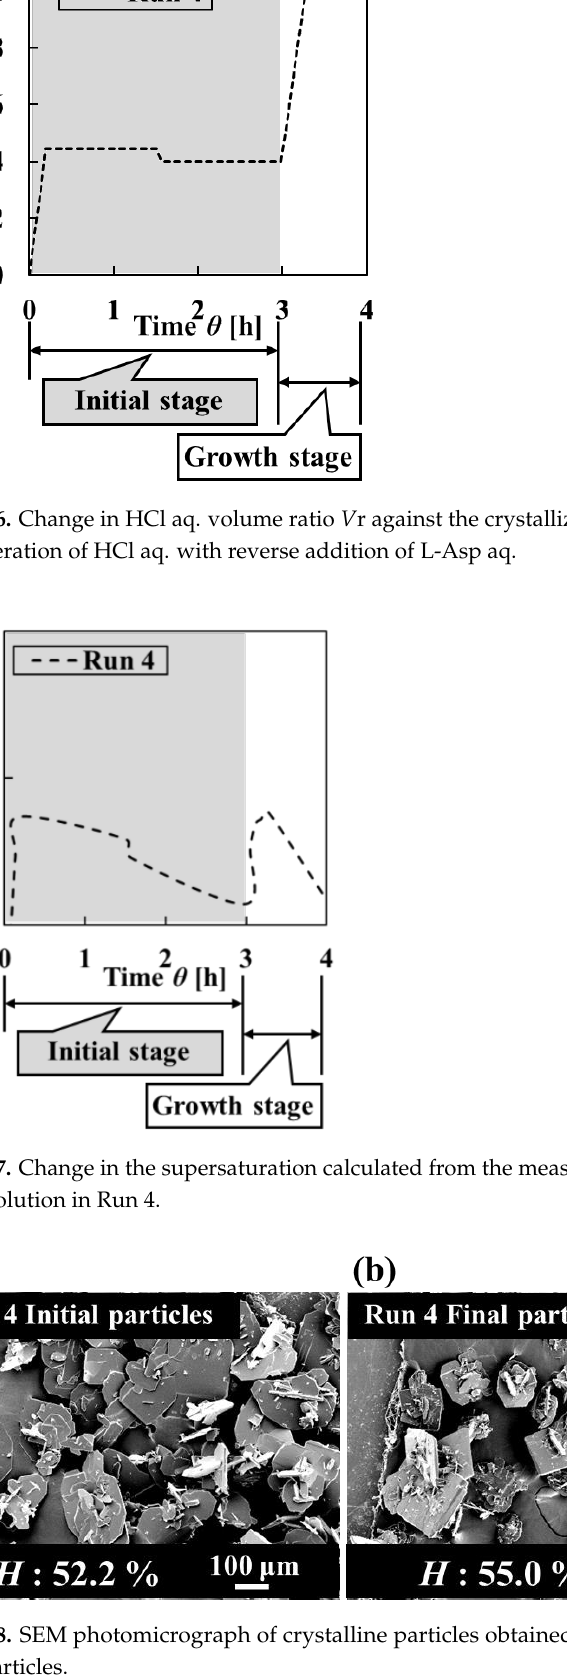
Figure 9. Dynamic variation in homogeneity and uniformity of the distributions of particle size and crystal shape with crystallization time in Run 4. 3.2. Proposed Operation Method in the Growth Stage In Run 5, in the initial stage, 104-mL HCl aq. was added to 225-mL L-AspNa aq. in the crystallizer as the first addition, and the mixed solution was held for 1 h and 30 min. Then, 25-mL L-AspNa aq. was added to the crystallizer as the second addition, and the mixed solution was held for 1 h. Subsequently, in the growth stage, 40-mL HCl was added to the crystallizer as the third addition, and the mixed solution was held for 20 min. Then, 40-mL HCl was added to the crystallizer as the fourth addition, and the mixed solution was held for 20 min, and 66-mL HCl was added to the crystallizer as the fifth addition, and the mixed solution was held for 50 min to obtain the final particles. This detailed addition method of Run 5 is shown in Table 3 and Figure 10. Table 3. The detailed addition methods in Run 5. Crystallization Stage